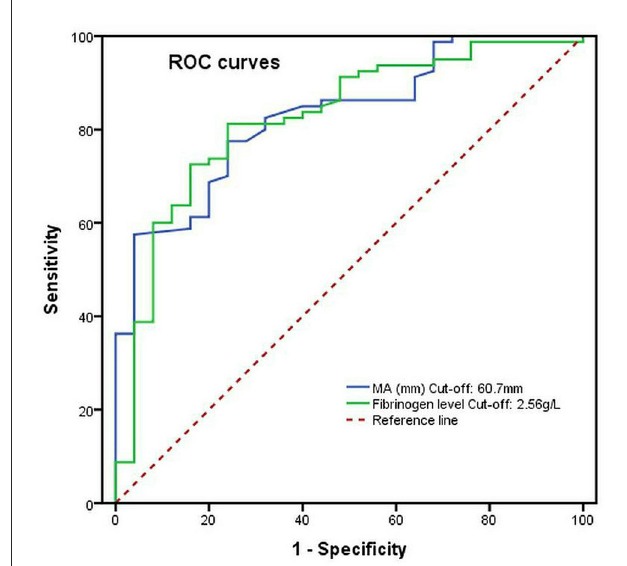
FIGURE4 The preoperative MA level (platelet function) and fibrinogen level as predictive values of risk factors for severe postoperative AKI (stage 3) in patients with ATAAD by the ROC curve